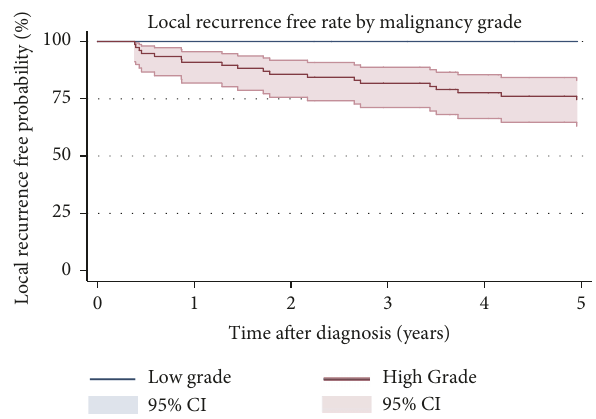
Figure 6: Kaplan-Meier estimates of local recurrence free rate by malignancy grade. 95% confidence intervals.